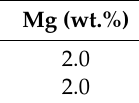
Table 6. Chemical elements in the weld joint after corrosion test. Sl.